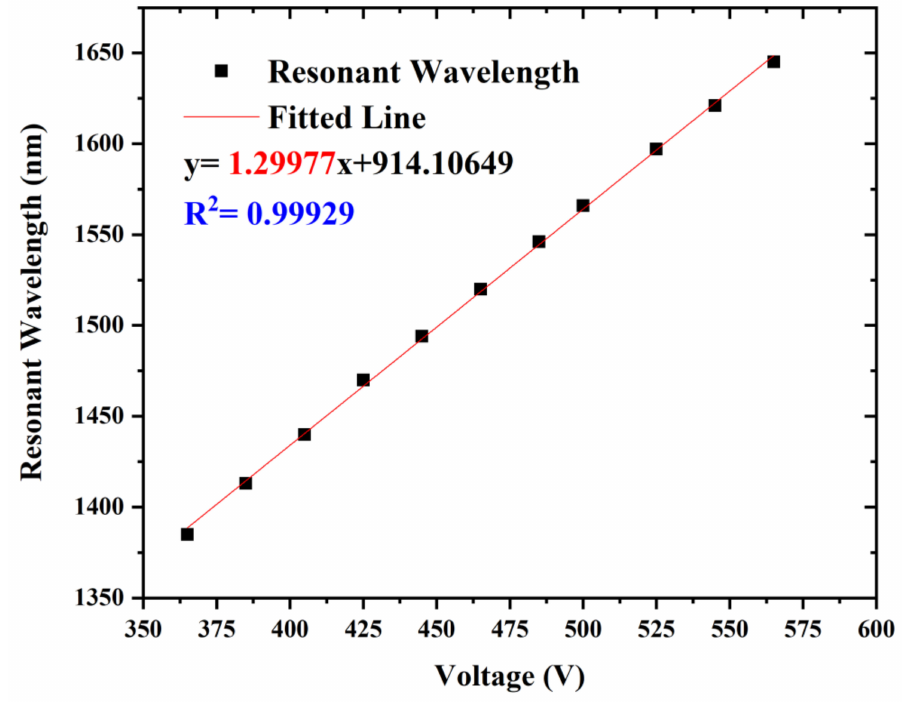
Figure 5. The resonant wavelength of the loss spectrum depending on the external voltage and its fitted